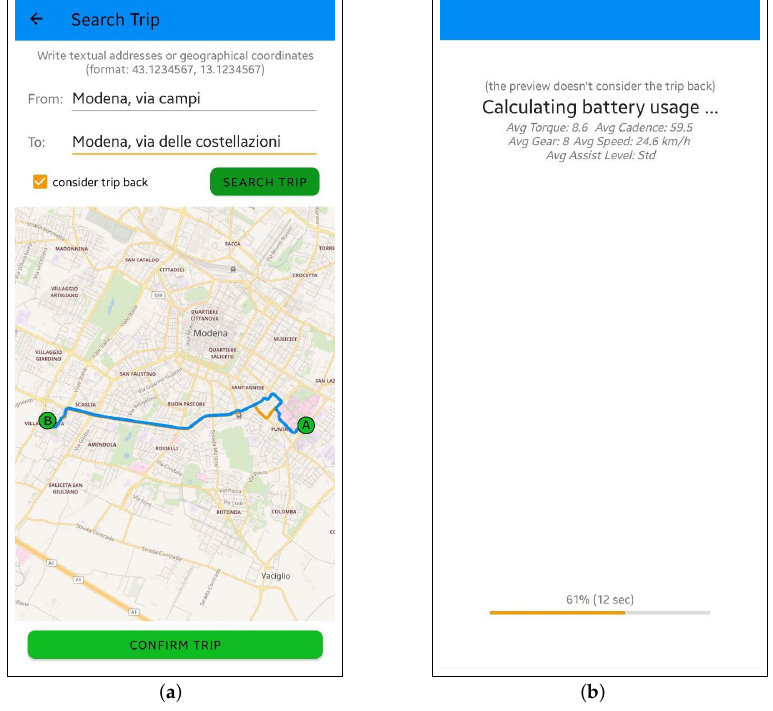
Figure 2. Path pages. ( a ) The page to search a path. ( b ) Loading